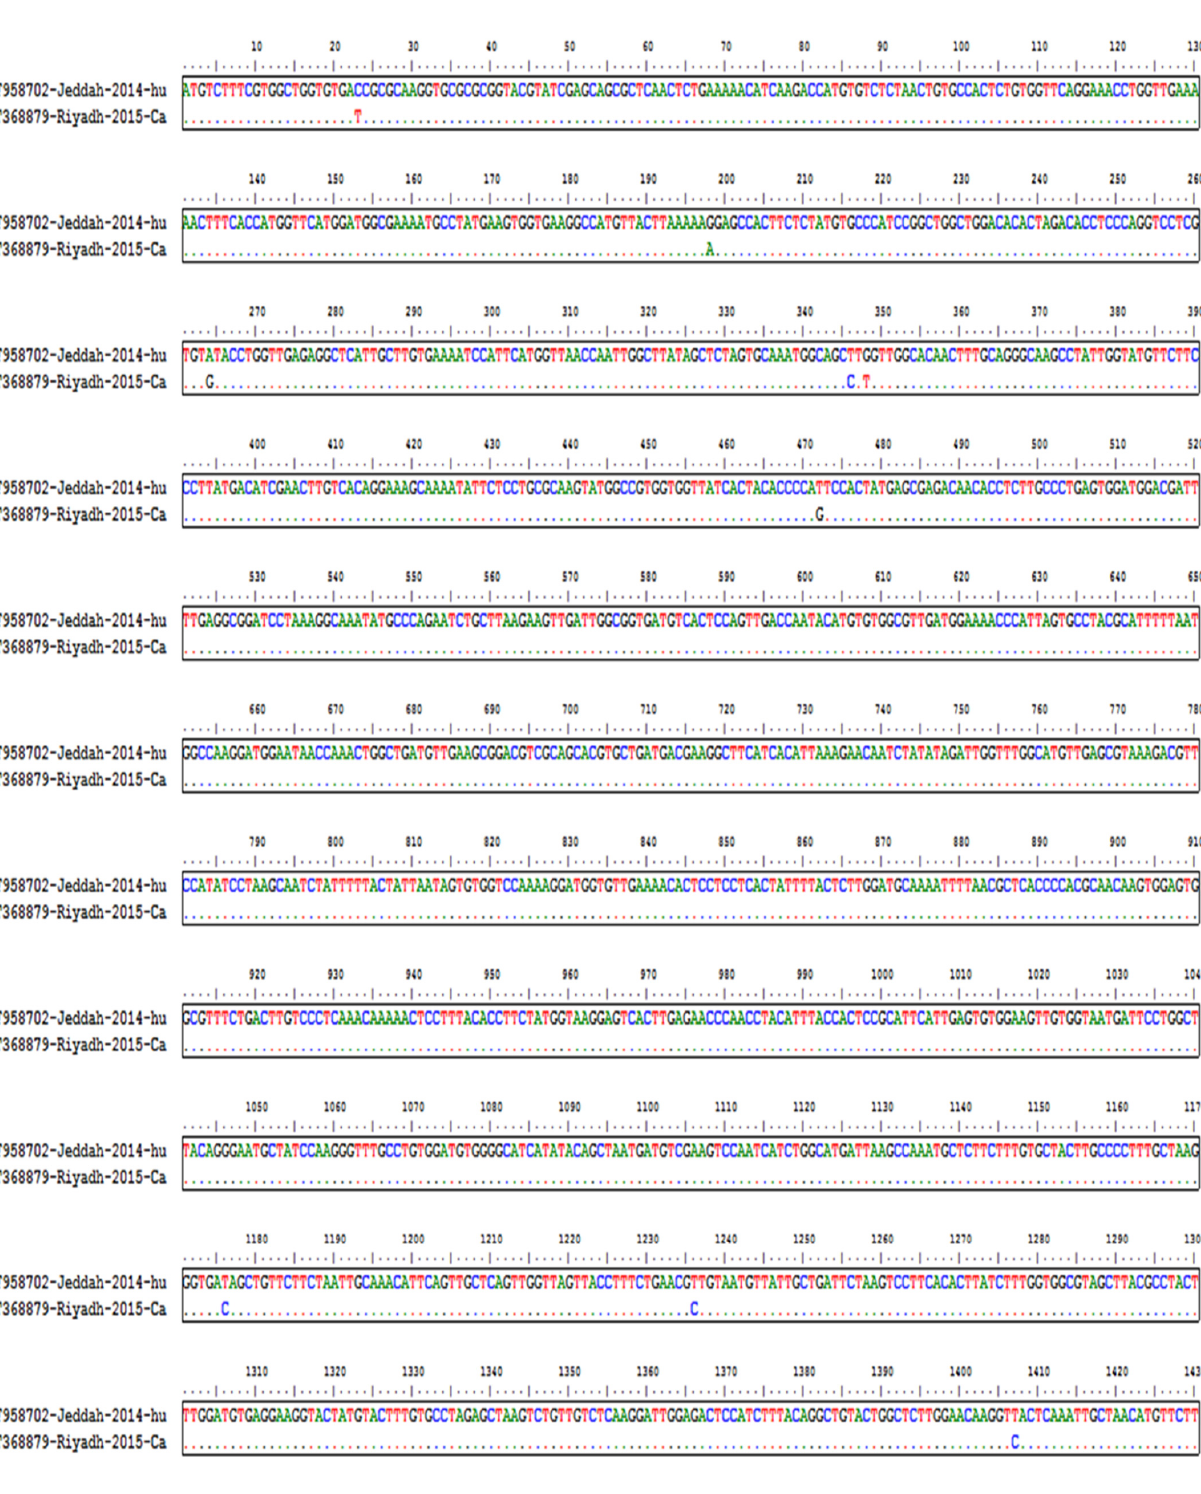
Figure 1. Multiple sequence alignment and homology of the MERS-CoV genome isolated from humans and camels. The figure shows good homology with very few variations in the viral genome.